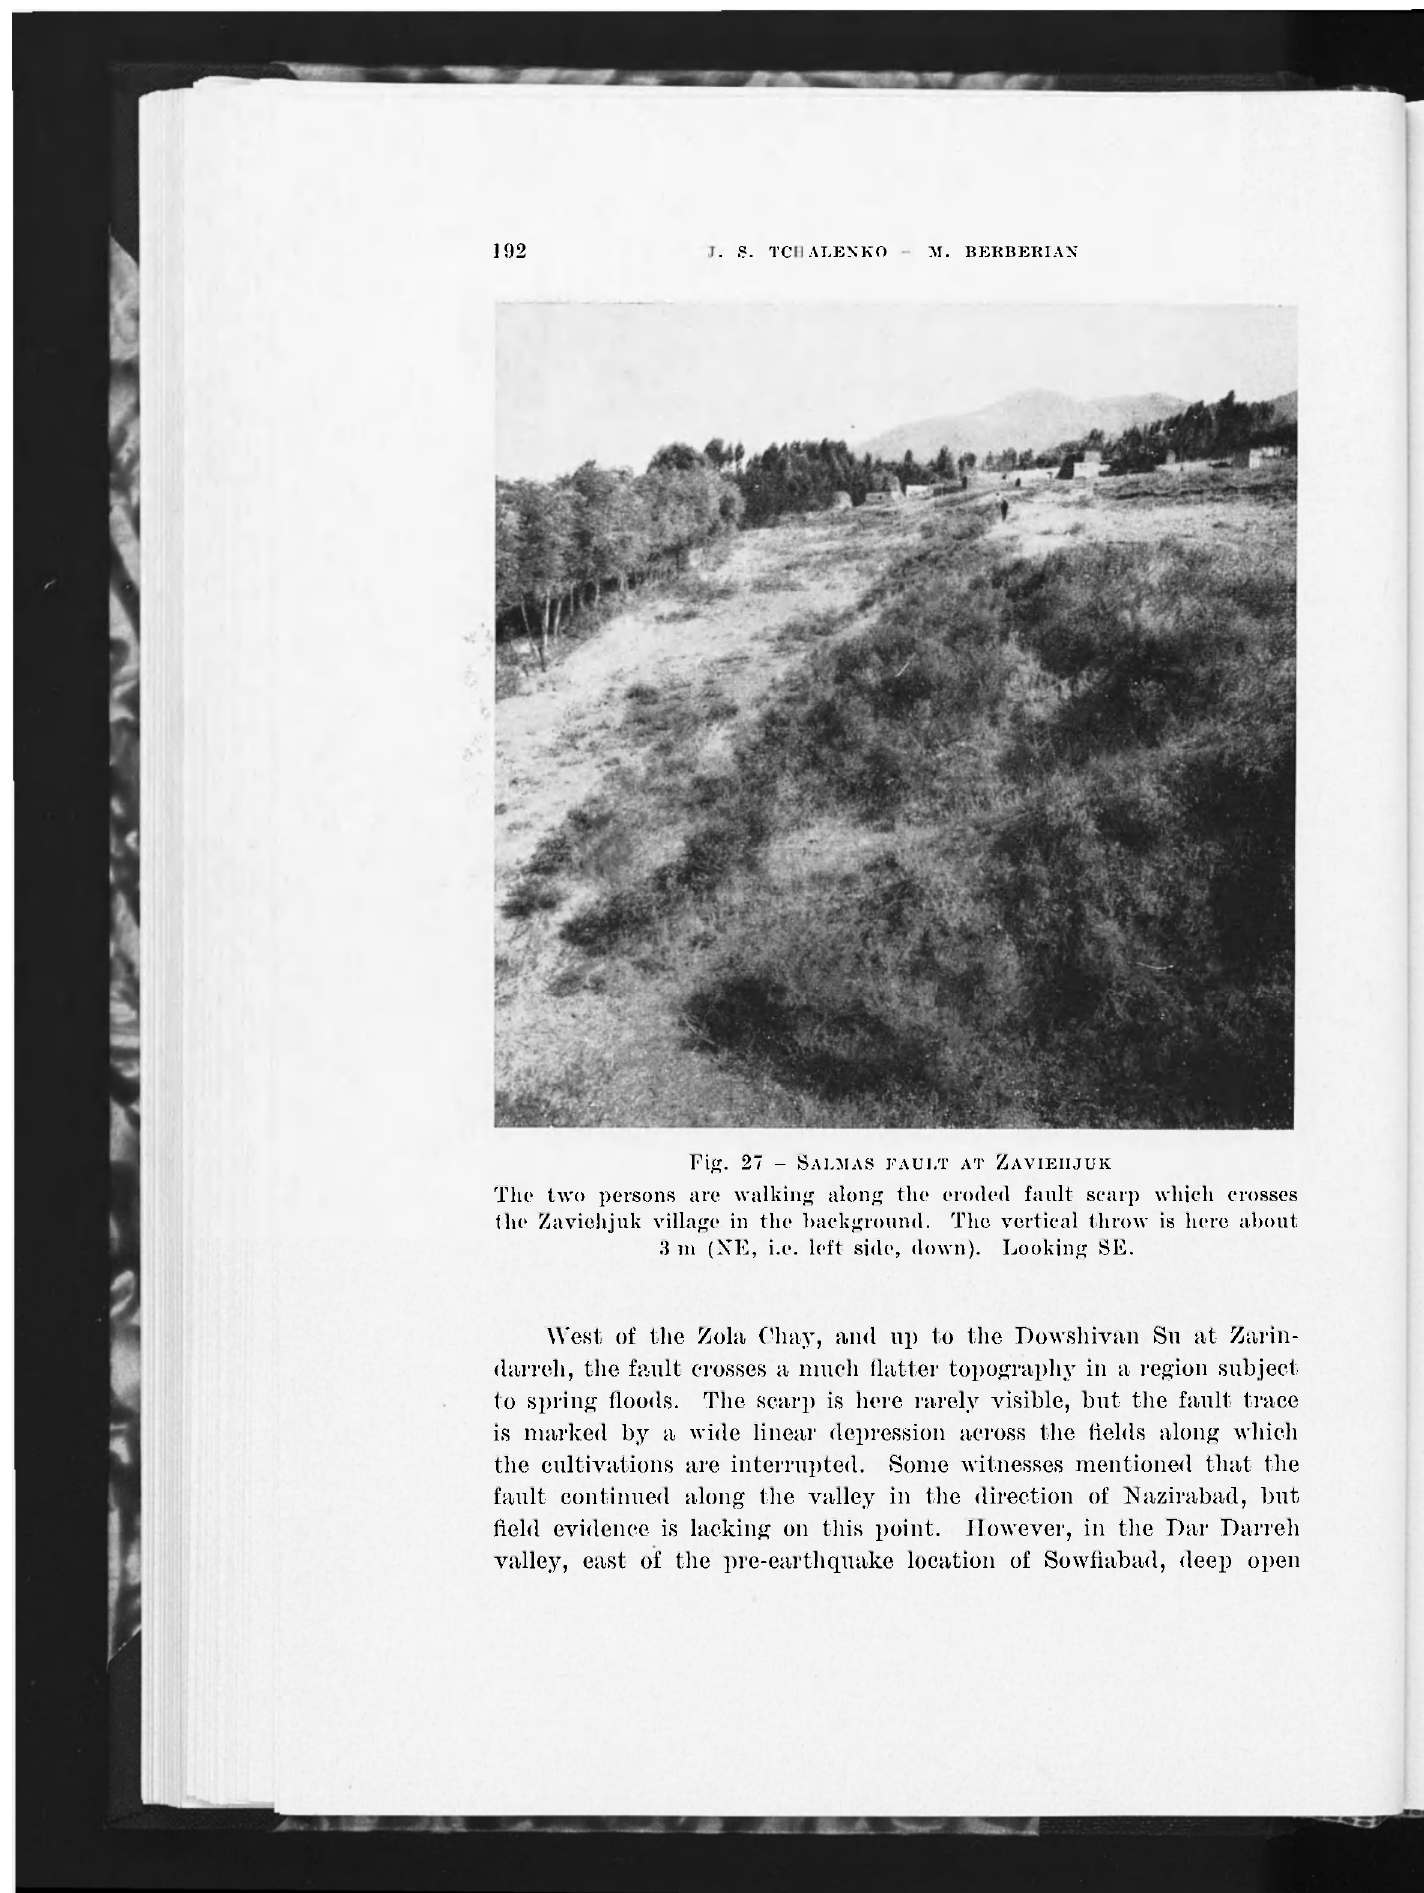
Fig. 27 - SALMAS FAULT AT